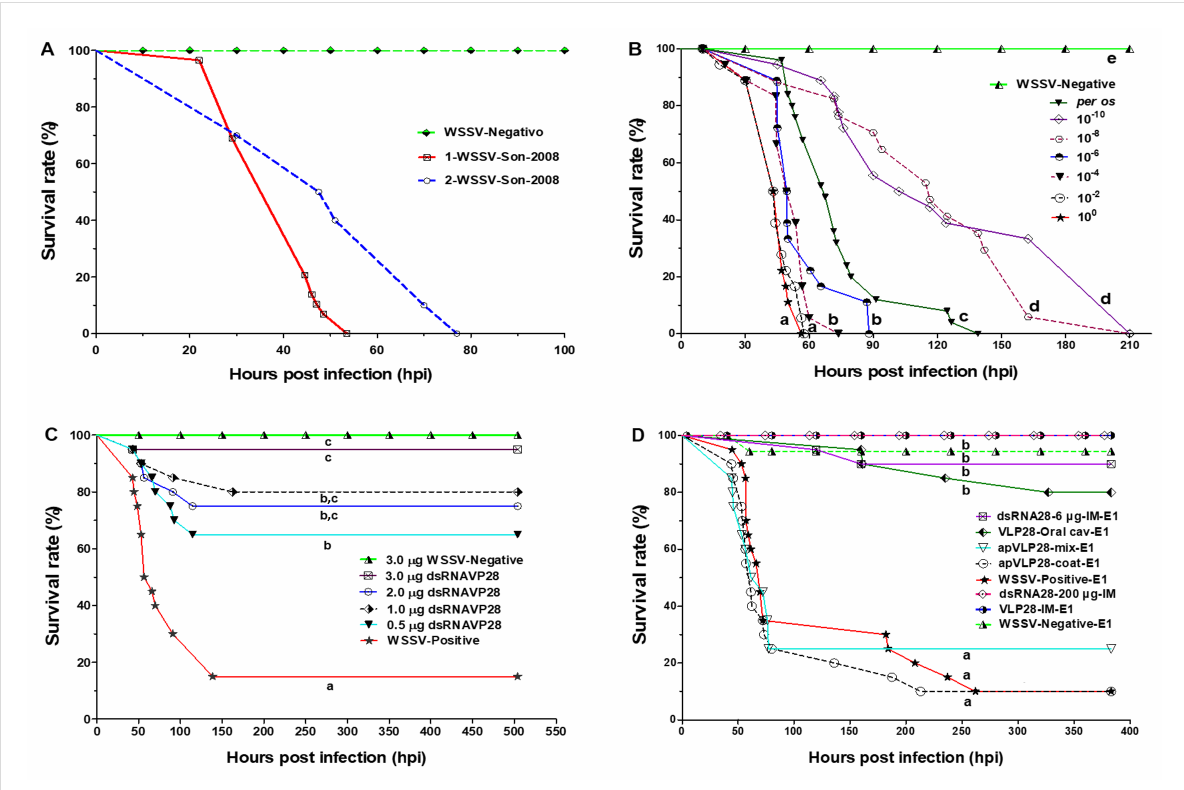
Figure 3: P. vannamei survival when exposed to WSSV and treatments. (A) IM inoculum activation in two consecutive experiments (1-WSSV- Son2008 and 2-WSSV-Son2008) (B) Per os infection with WSSV-Son2008 isolate to determine the LD 50 /mL (C) IM dsRNAvp28 at 3.0, 2.0, 1.0, and 0.5 µg, WSSV-Negative control received a 3.0 µg dose. The survival was evaluated up to 504 hpi (21 days). (D) Oral antiviral treatment with VLP- dsRNAvp28 (6 µg per shrimp) in the pellet with fish oil (industrial grade) as a binding agent. Different letters (a–d) in each experiment (B, C, and D) on the curves indicate significant differences ( p < 0.0001) among treatments using the Log-rank (Mantel–Cox) Test and not the final absolute survival percentage. IM, intramuscular injection, see Table ST4 (Supporting Information File 1) for treatment abbreviature details.